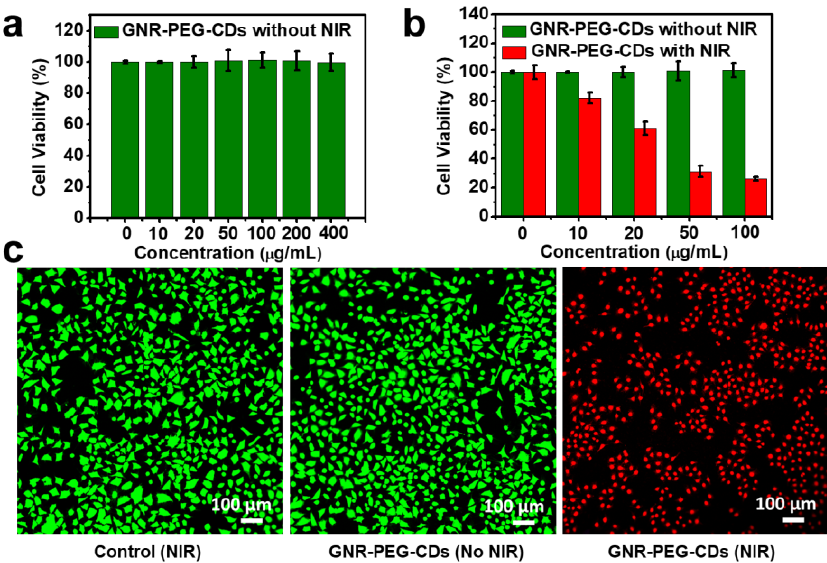
Figure 6. ( a ) In vitro viability results of HeLa cells treated using GNR-PEG-CDs without lasers irradiation (from 0 to 400 µg mL − 1 ); ( b ) in vitro viability results of HeLa cells treated with GNR-PEG-CDs (from 0 to 100 µg mL − 1 ); ( c ) CLSM images of GNR-PEG-CDs (100 µg mL − 1 ) before and after NIR irradiation with Calcein-acetoxymethylester and propidium iodide (PI) co-staining. Scale bars: 100 μm.